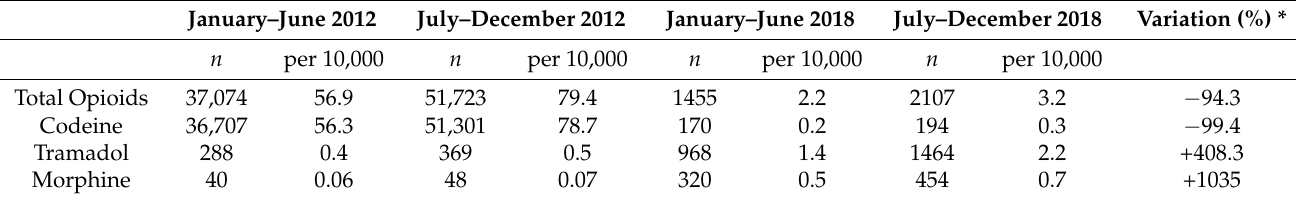
Table 3. Number of children aged 0 to 2 years who received an opioid, comparison of year 2012 and year